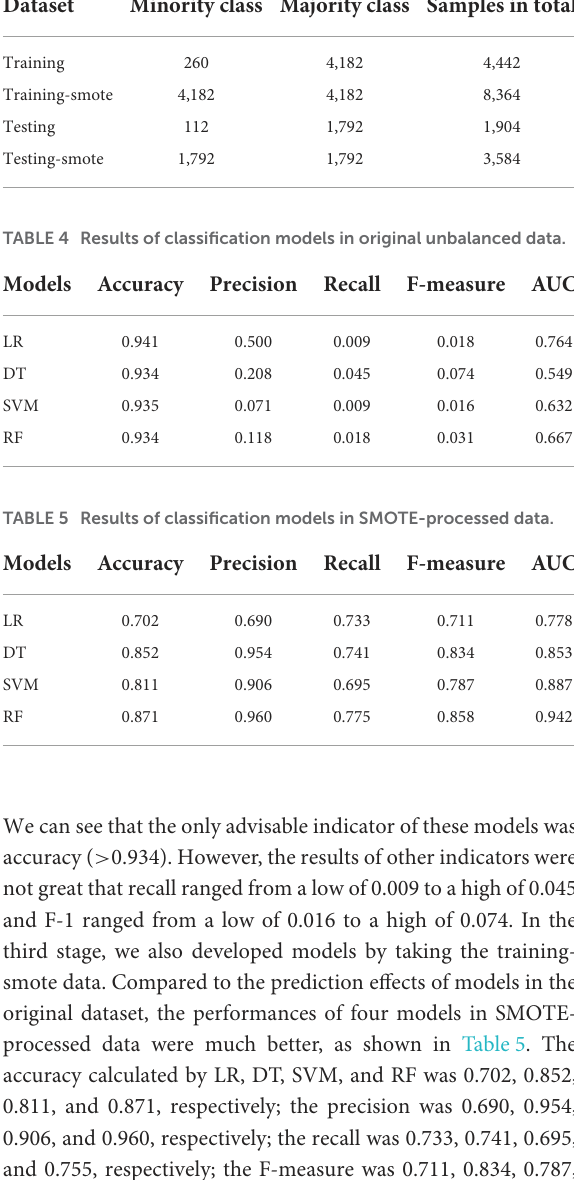
TABLE 3 Description of original data and SMOTE-processed data.